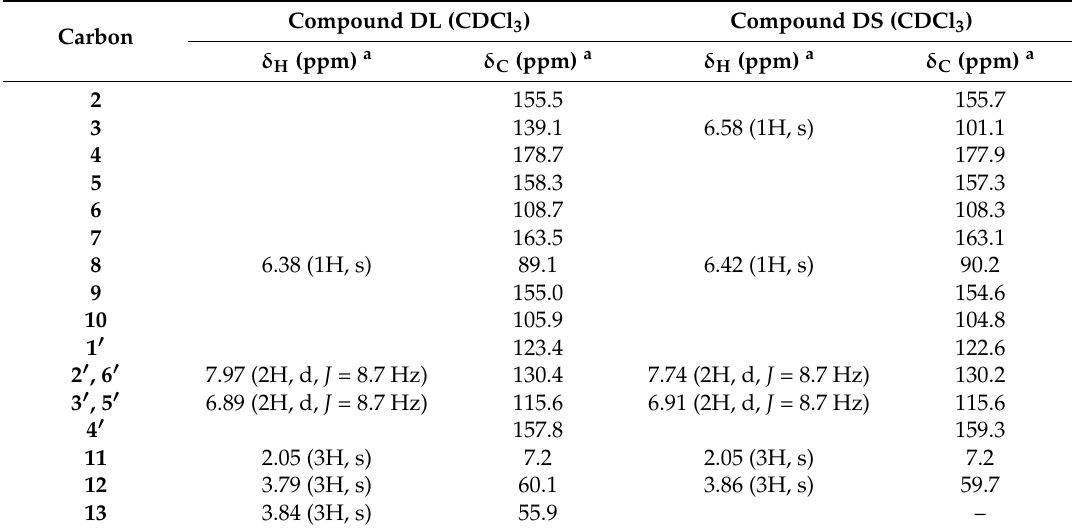
Table 2. 1 H- (600 MHz) and 13 C-NMR (151 MHz) data for compounds DL and DS